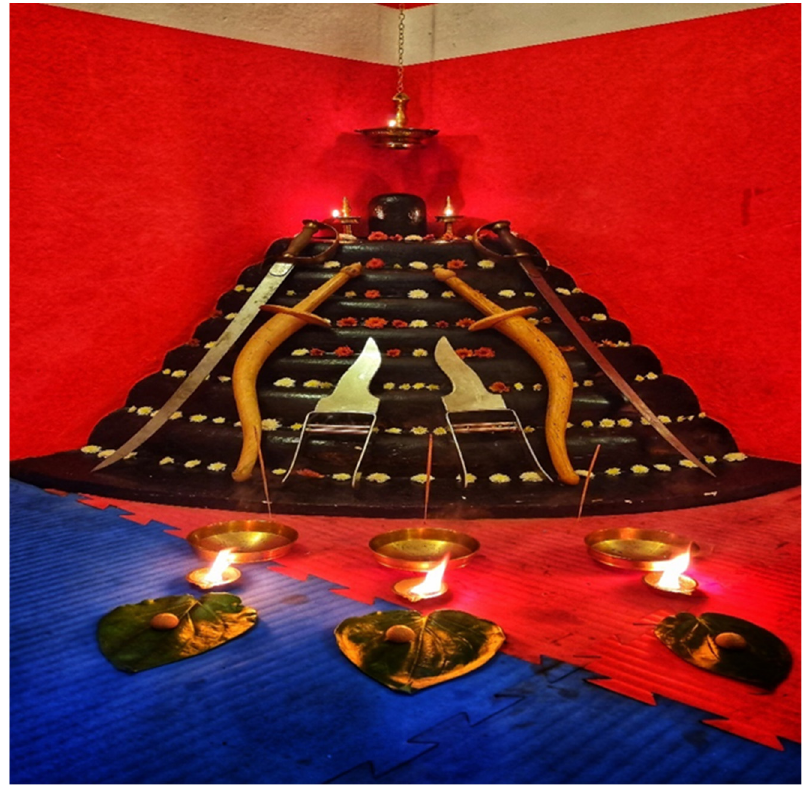
Figure 4. p ū tta ṟ a in a N ā yar ka ḷ ari . Photo by Nishanth V. Kunnu. Figure 4. p¯uttar ¯a in a N¯ayar kal.ari . Photo by Nishanth V.